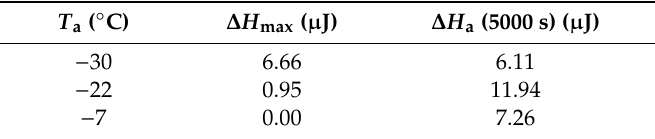
Figure 6. Determination procedure of the enthalpy change during annealing. ( a ) Measurement of the enthalpy relaxation of amorphous NBR. The lower curves are measured after annealing at − 30 °C for 0 s (black) and 10,000 s (red). The upper curve is the differences of both curves. The enthalpy was determined by integration. ( b ) Evaluation of the curves of semicrystalline HNBR after annealing at –30 °C, –22 °C, and − 7 °C. The measurement curves after 0 s and 5000 s are shown below. The black curves are measured without annealing. The upper curves show the differences, which were used for the evaluation of the enthalpy by integration. Table 1. Maximum annealing enthalpy Δ H max (Equation (11)) and the measured enthalpy of annealing after Δ H a (5000 s) (Figure 6b) for selected annealing temperatures of HNBR.